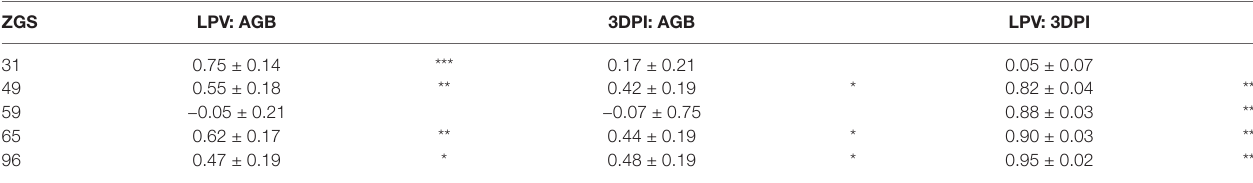
TABLE 6 | Pearson’s correlation coefficients (r), between LiDAR Projected Volume (LPV), 3DPI and Above-ground Biomass (AGB), for each sample time (ZGS) at Roseworthy. ZGS LPV: AGB 3DPI: AGB LPV: 3DPI